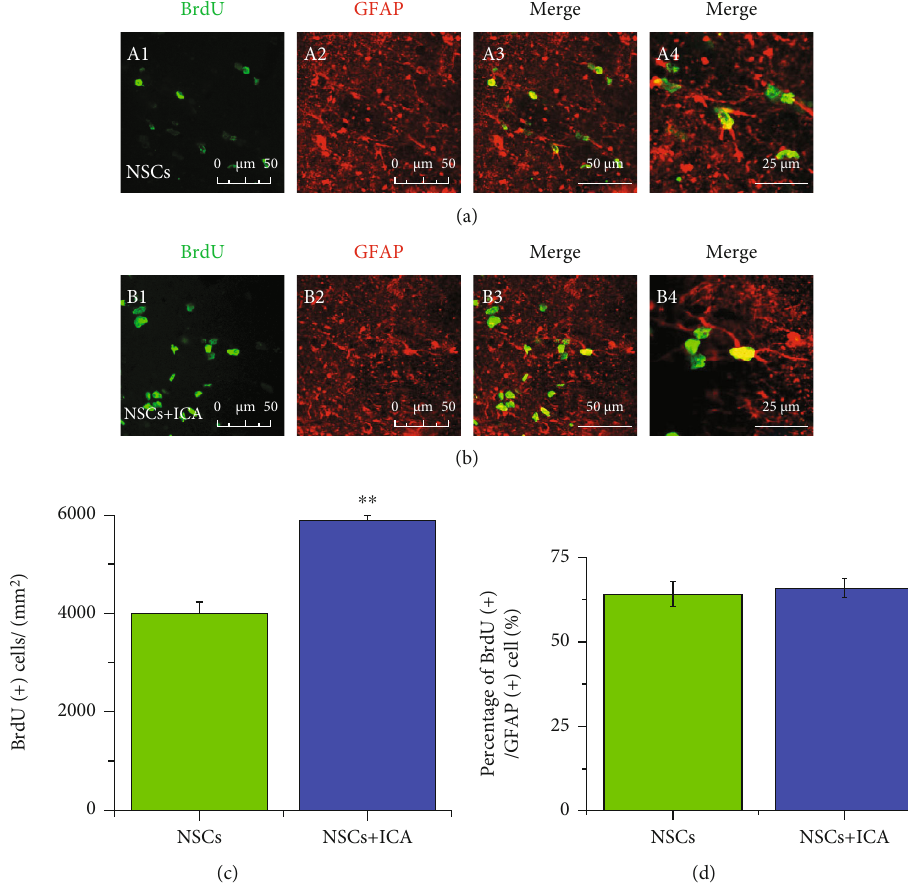
Figure 5: ICA treatment increased the total number of astrocytes di ff erentiated from transplanted NSCs in the FFT rat model. Double immuno fl uorescent staining of BrdU and GFAP was applied to detect the number of astrocytes di ff erentiated from NSCs of the (a) NSC transplantation group and (b) NSC + ICA group. Scale bar = 50 μ m (A1 – 3, B1 – 3); 25 μ m (A4, B4). (c) Quantitative analysis of the number of GFAP(+)- and BrdU(+)-positive cells in vivo . (d) Quantitative analysis of the percentage of BrdU(+)/GFAP(+) cells to BrdU(+) cells in vivo . Data are expressed as the mean ± SEM , n = 3 . ∗ P < 0 : 05 and ∗∗ P < 0 : 01 , the NSC + ICA group vs the NSC transplantation